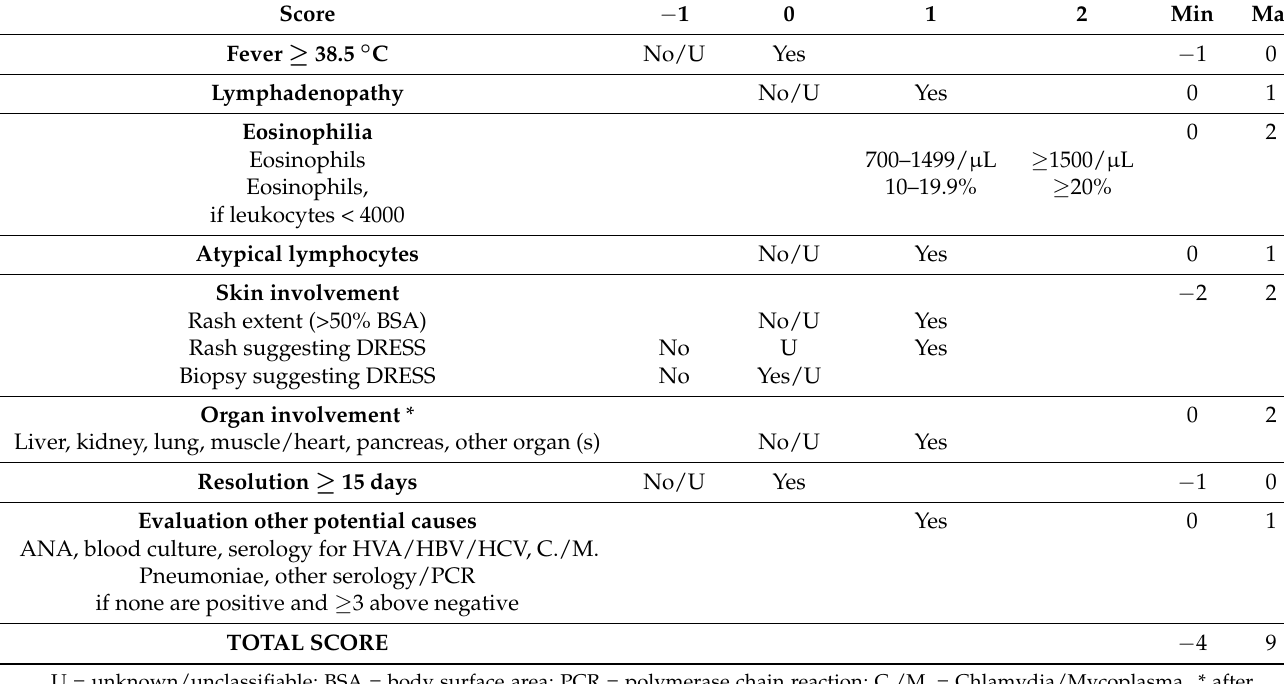
Table 2. RegiSCAR score system. Table modified from Kardaun et al.